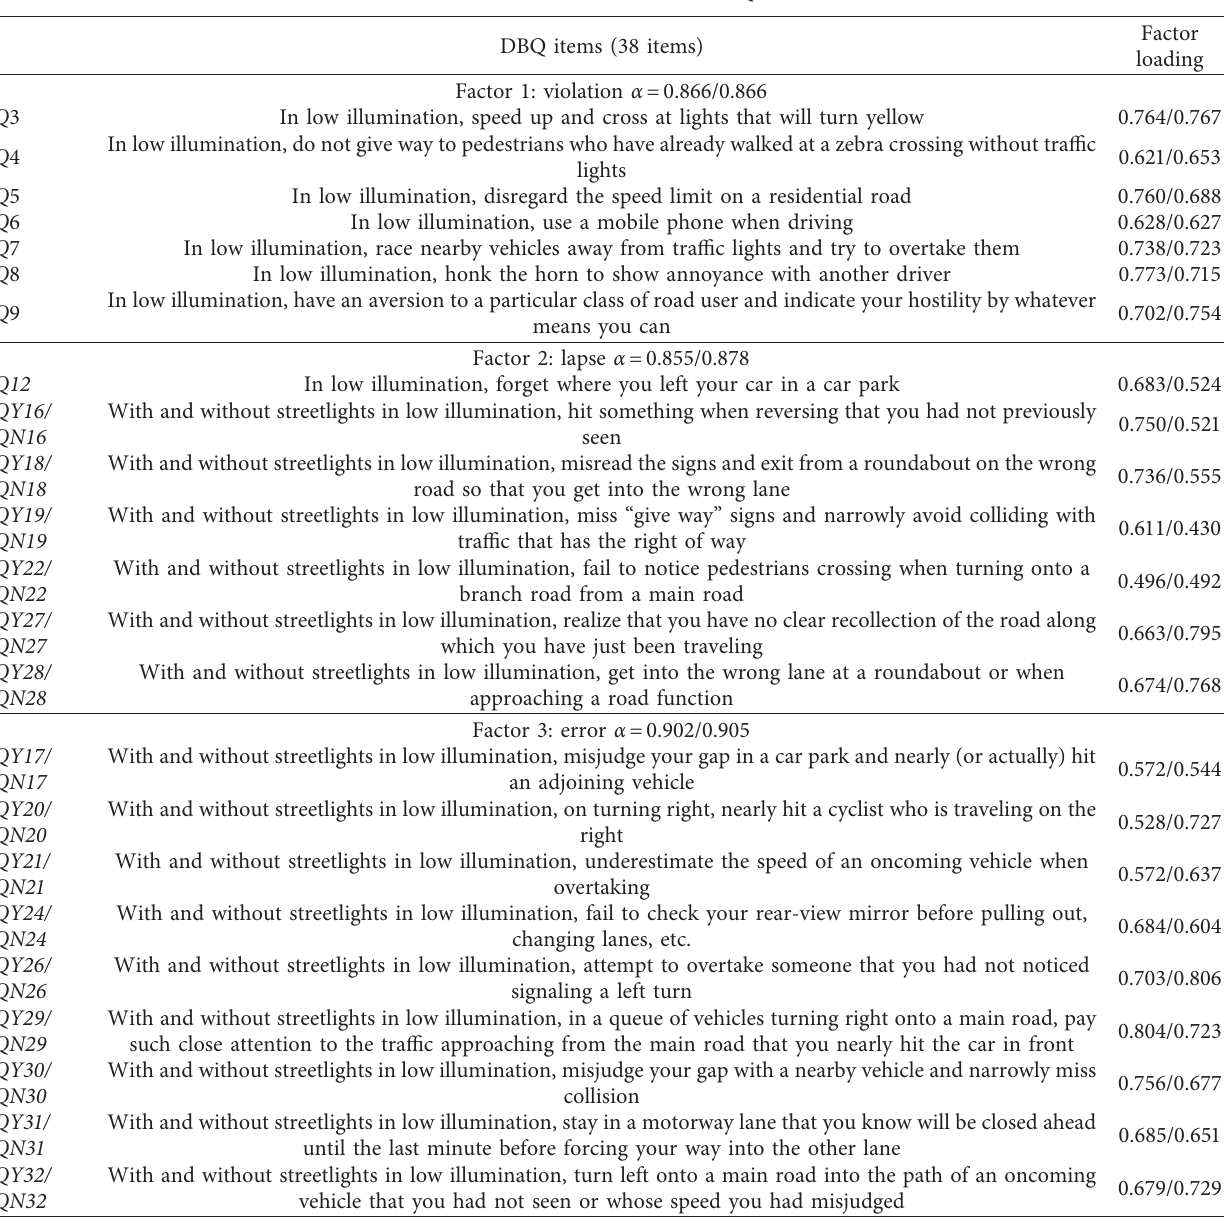
Table 6: Factor structure of the DBQ